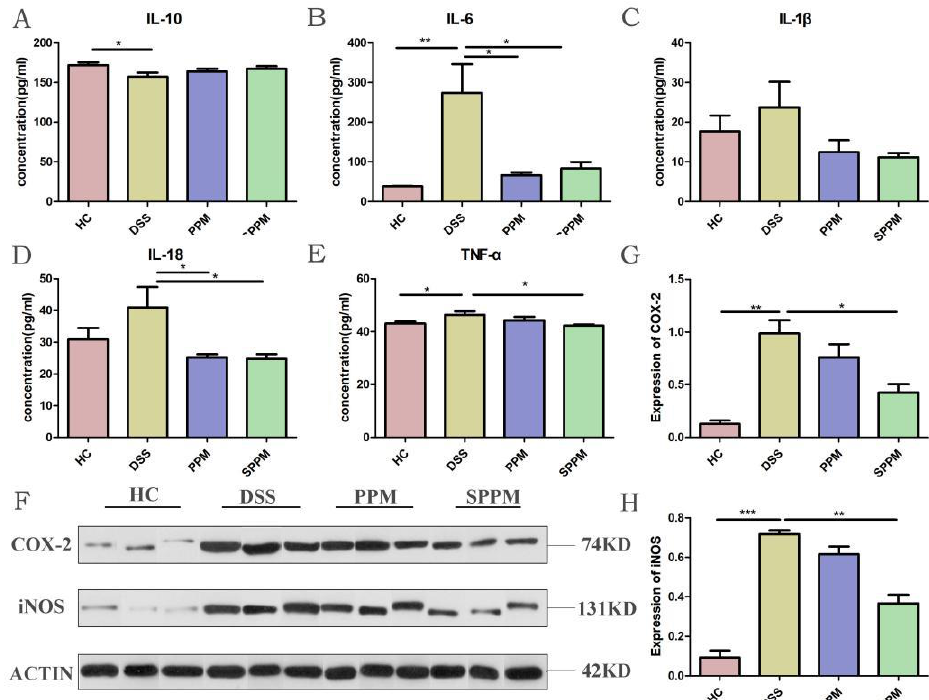
Figure 3. Effects of PPM60-III and SPPM60-III on inflammatory factors and related enzymes in mice. ( A ) The expression of IL-10; ( B ) the expression of IL-6; ( C ) the expression of IL-18; ( D ) the expression of IL- 1β; ( E ) the expression of TNF- α; ( F ) Western blotting of Cox-2 and iNOS; ( G ) Cox-2 protein expression; ( H ) iNOS protein expression. * p < 0.05, ** p < 0.01, *** p < 0.001.